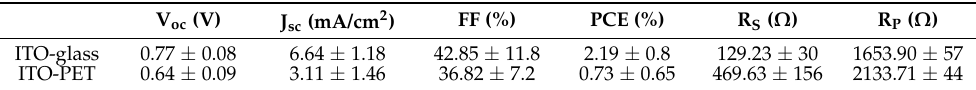
Table 2. Summary of the photovoltaic parameters for DPP(TBFu) 2 :PC61BM cells fabricated onto glass and PET applying the TA treatment at 110 ◦ C. Average values are the result of measuring 10 diodes. Rs and Rp mean sheet and parallel resistance,